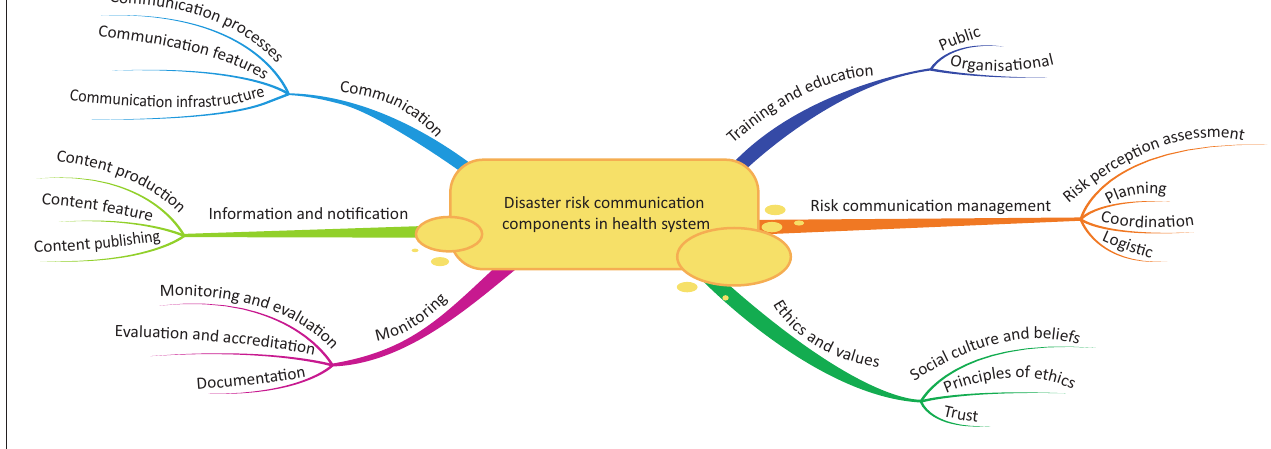
FIGURE 2: Disaster risk communication components in the health system, extracted from thematic